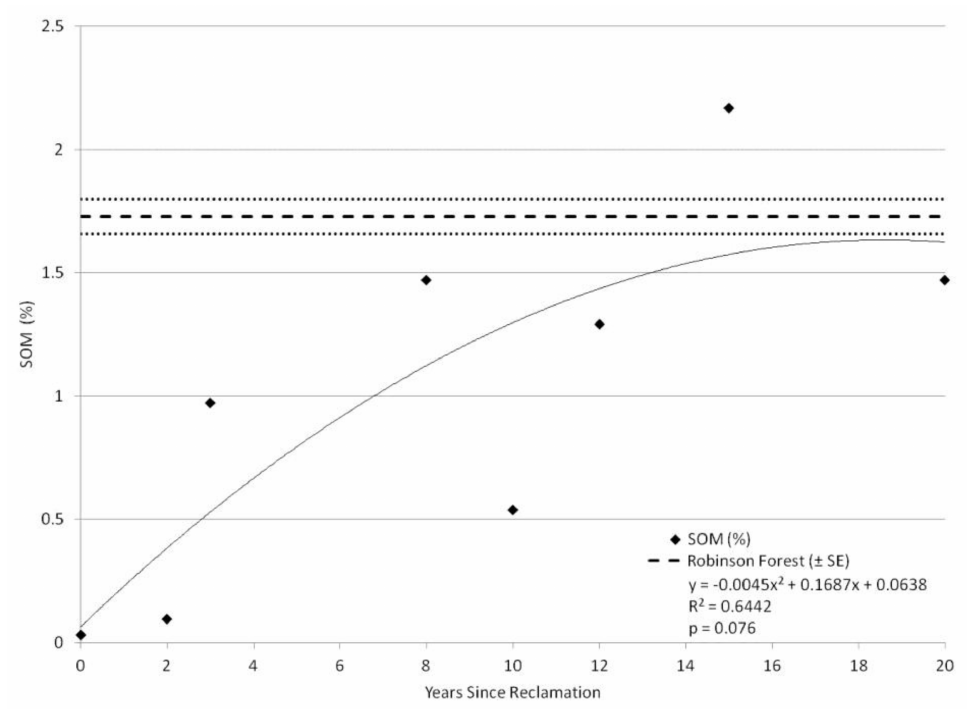
Figure 4. Changes in soil organic matter (SOM; thermogravimetric analysis) in mine soils over time since reclamation, with mean % SOM ( ± SE) for Robinson Forest plotted for reference.